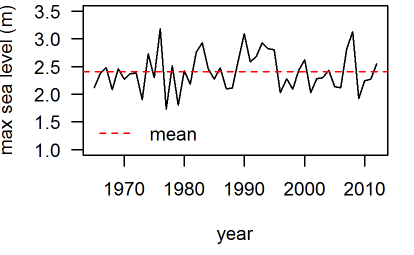
Figure 4. Yearly maximum sea level. Yearly maximum sea level as measured at the tide station of West-Terschelling (1965–2012).